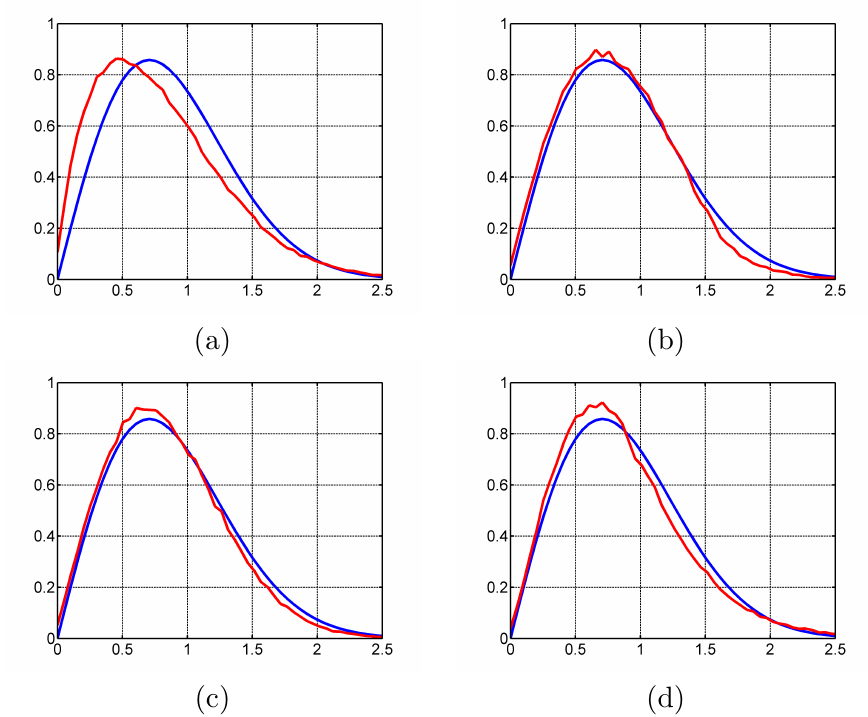
Figure 9. Rome test case: overlapping of the theoretical speckle PDF (blue line) and of the ratio images (red line) in amplitude format in the case of: ( a ) Kuan, ( b ) PPB-it, ( c ) FANS, and ( d ) EWF.